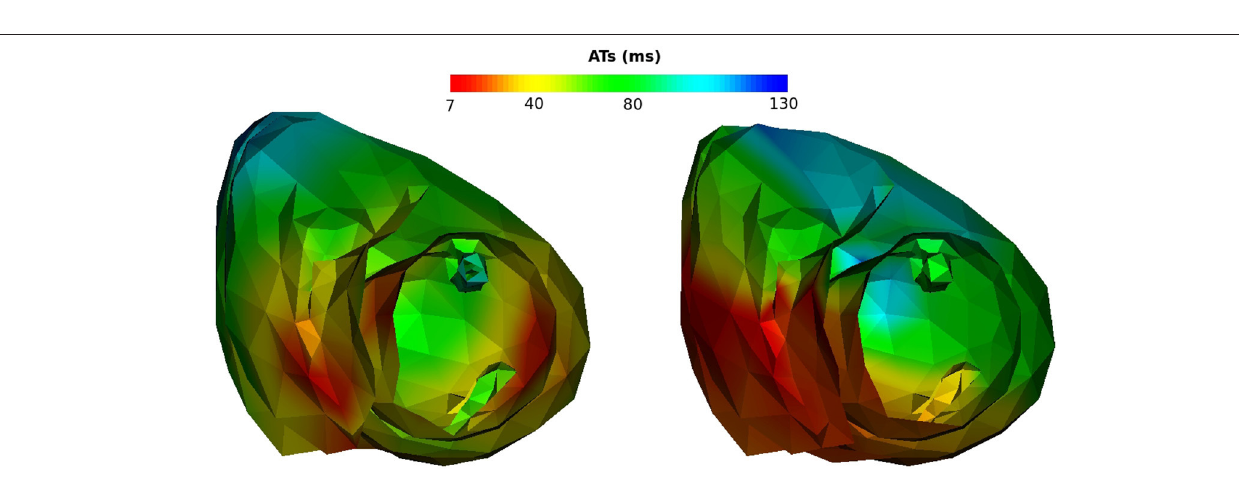
closed surface of the epicardium alone, and the other including both epicardium and endocardium. Tests were performed using in silico data for a sinus beat and six different ventricularly paced beats. Results were very similar for both meshes in 6 cases: all the characteristics we looked at were of the same good quality. The presence of the endocardium slightly improved the ATs on the epicardium. In contrast, for the RTs the effect of including the endocardium was variable.